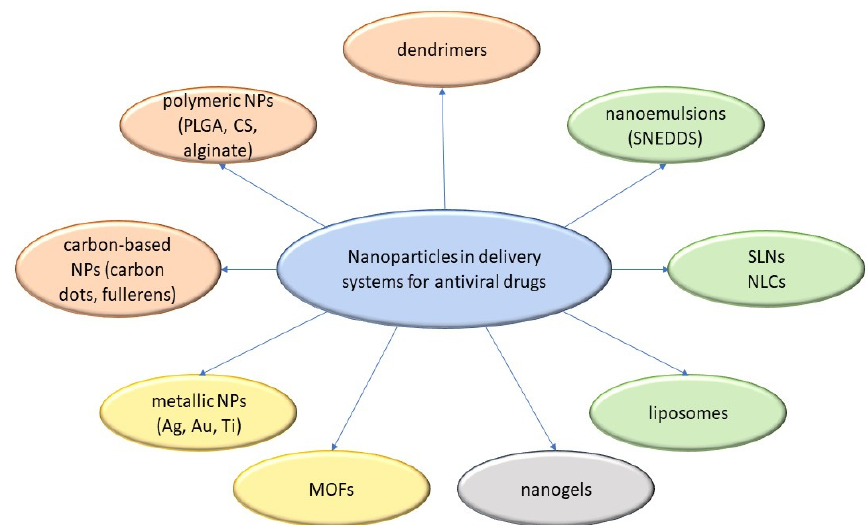
Figure 2. Different types of nanoparticles used as carriers for antiviral drugs.